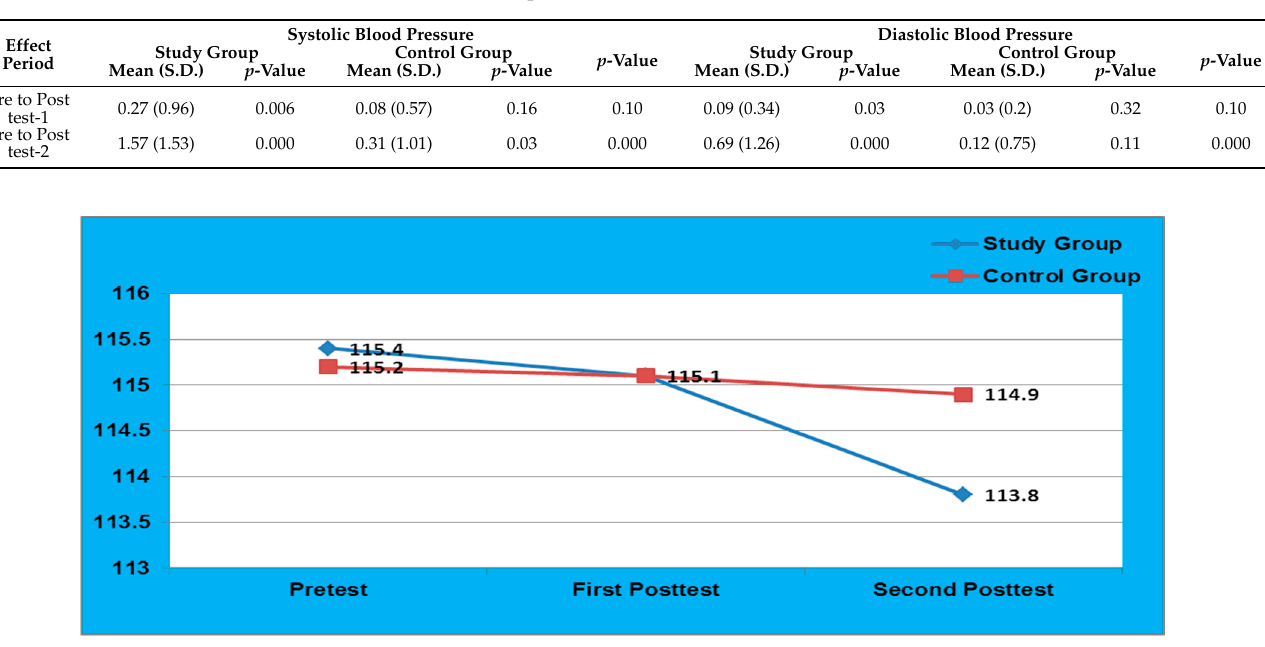
Table 2. Comparison of Effective score for B.P.